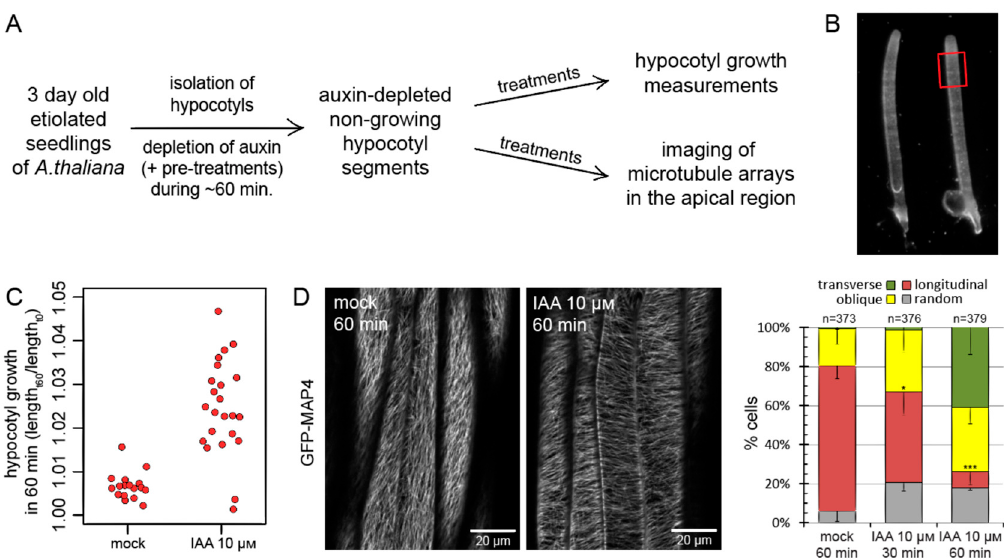
Figure 2. Auxin-induced reorientation of cortical microtubules in isolated hypocotyl segments of A. thaliana . ( A ) An overview of the experimental setup used throughout this study. Hypocotyls were isolated from three-day-old etiolated seedlings of A. thaliana . The depletion of endogenous auxin and the resulting cessation of growth was allowed within following time of around one hour. Necessary chemical pre-treatments were applied in this period. Hypocotyls were then transferred to treatment media (e.g., containing auxin) and imaged by CLSM typically after one hour of treatments, or they were placed on a flatbed scanner for growth measurements. See Section 4 for details. ( B ) Isolated A. thaliana hypocotyls used in this study. Red rectangle marks the sub-apical region of active growth in three-day-old hypocotyls, where the orientations of microtubules were scored. ( C ) Auxin-induced growth of isolated A. thaliana hypocotyls. Auxin-depleted hypocotyls were placed on control or auxin-supplemented (IAA, 10 µ M) media, and their growth was measured over a one hour period. The graph shows collated growth measurements from three experiments, each data point representing one hypocotyl. ( D ) Concomitant with growth, auxin (IAA, 10 µ M) causes the reorientation of cortical microtubule arrays in the outer faces of hypocotyl epidermis, from predominantly longitudinal into predominantly oblique and transverse. Cells were scored into four categories based on the prevalent type of microtubule array observed. The GFP fluorescence is depicted in grayscale. The graph shows average percentage of cells in each category from three experiments. Error bars indicate standard deviation (only the lower bar is shown for clarity). Total cell numbers are given above the graph. The frequencies of cells with longitudinal arrays were compared with the mock treatment using t tests, p = 0.022 (*) for 30 min auxin treatment and p = 0.0003 (***) for 60 min auxin treatment.